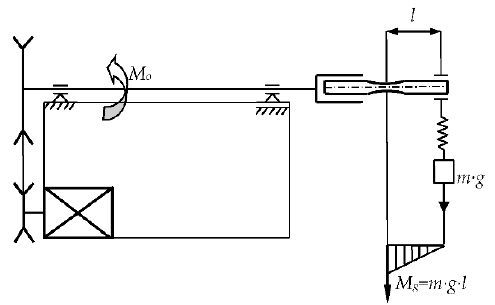
Figure 2. Scheme of test equipment for rotating bending.